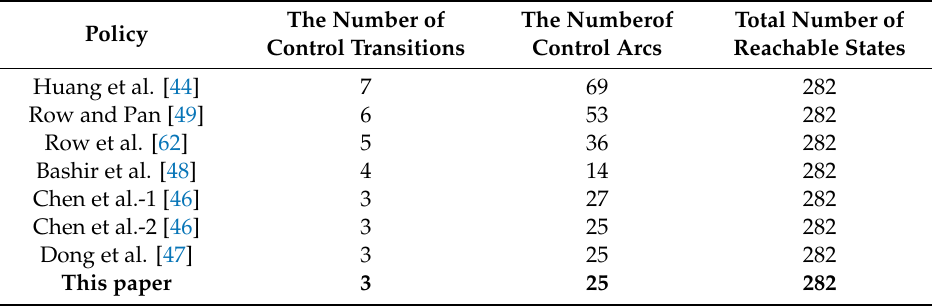
Table 9. Comparisons with existing literature in Example